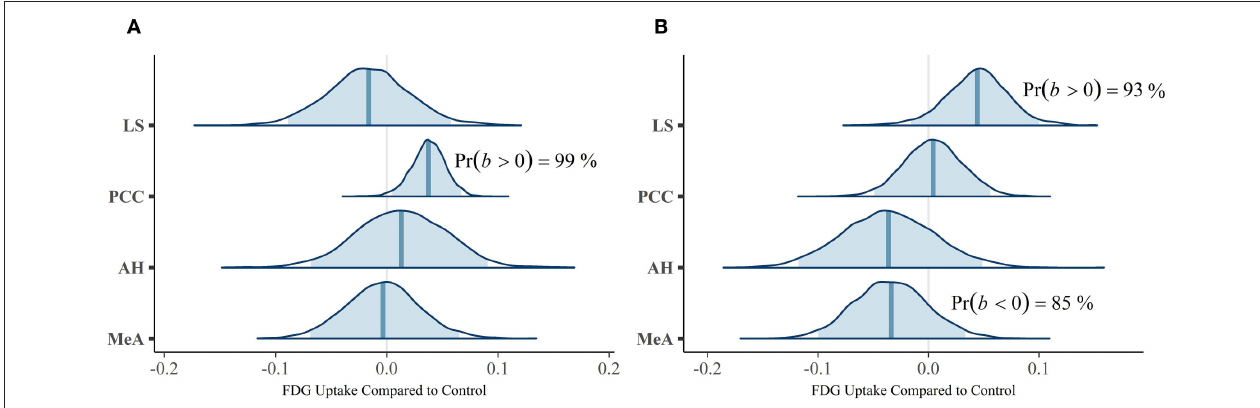
FIGURE 3 | Posterior distributions from the multivariate multilevel mate guarding model. The density plots are the parameter estimates (contrasts from the control group). The shaded blue regions are the 95% credible regions, while the dark blue lines are the point estimates. (A) Left ROIs. (B) Right ROIs.